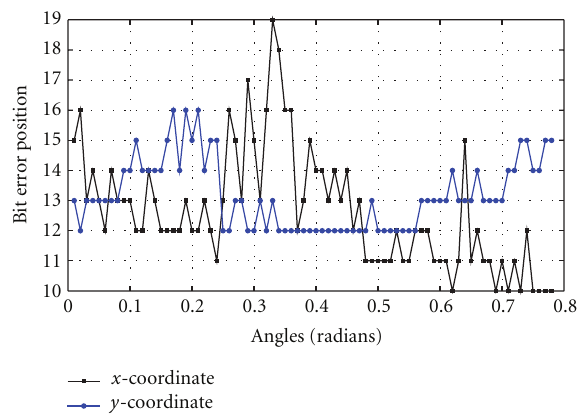
Figure 2: Bit error position in coordinate values calculated using the proposed CORDIC